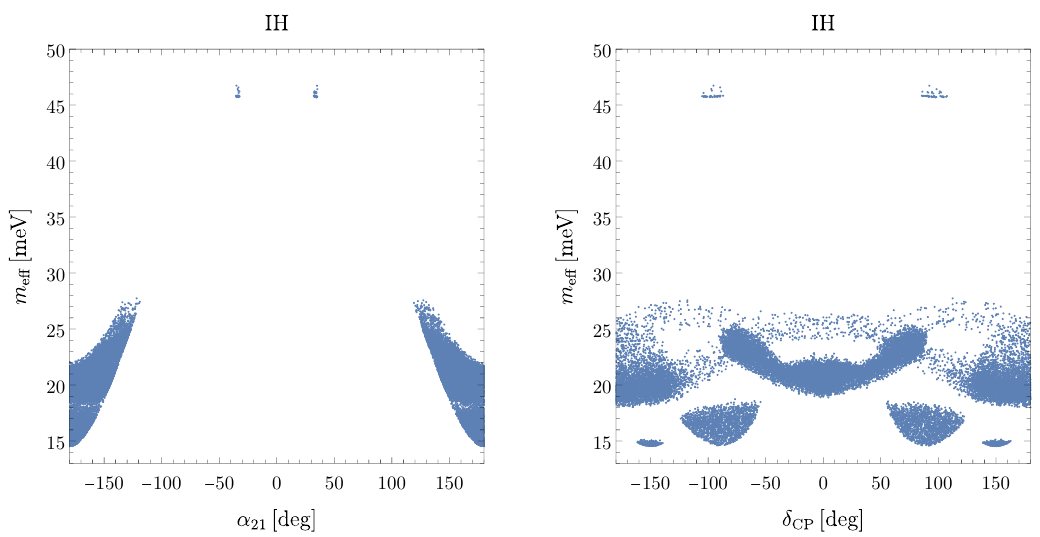
Figure 3 . Predicted effective neutrino mass of neutrinoless double beta decay as a function of the Majorana CP phase (left) and the Dirac CP phase (right), calculated from the results given in figure